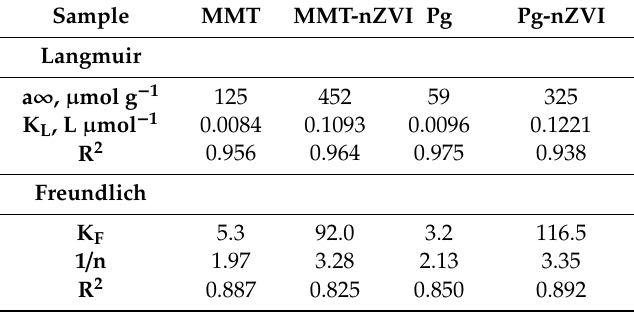
Table 2. Langmuir and Freundlich parameters for the adsorption of uranyl ions onto pristine and nZVI-modified minerals.